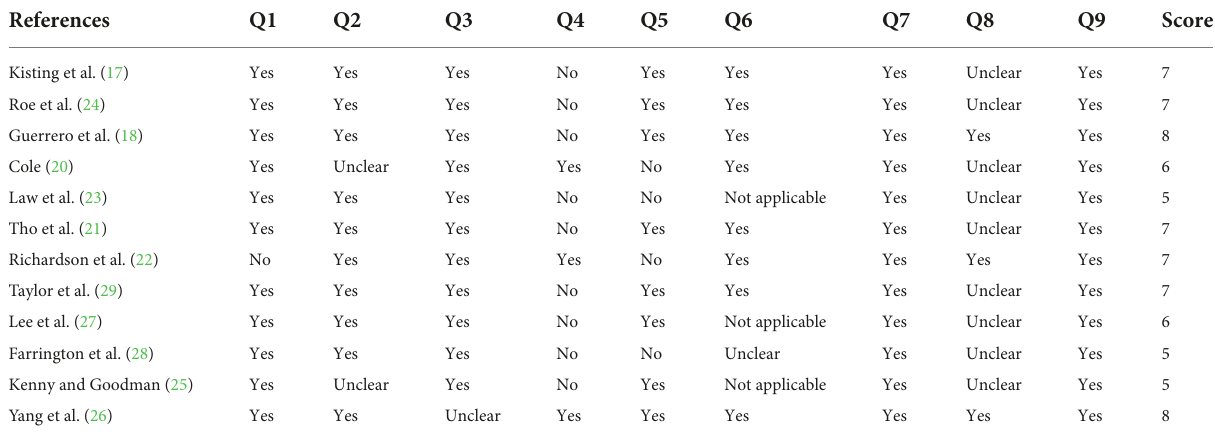
TABLE 1 Results of critical appraisal ( n =